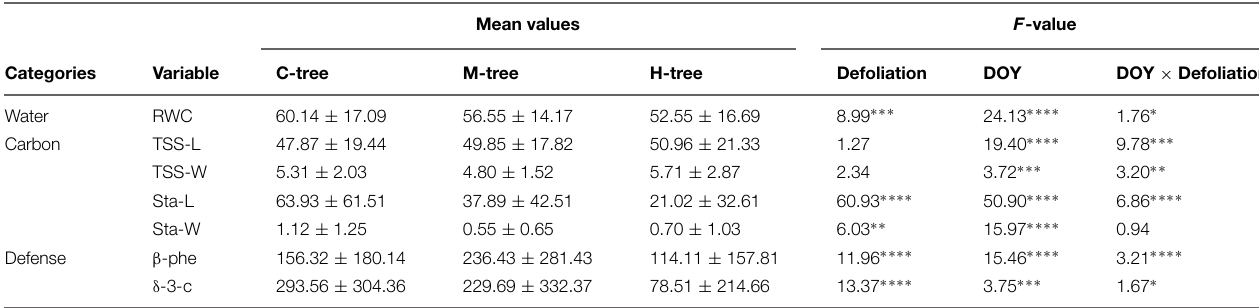
TABLE 3 | Mean seasonal values and effect of defoliation class on the measured variables in the leaf and wood (C-, M-, and H-tree are control, moderately and heavily defoliated trees). Mean values F -value